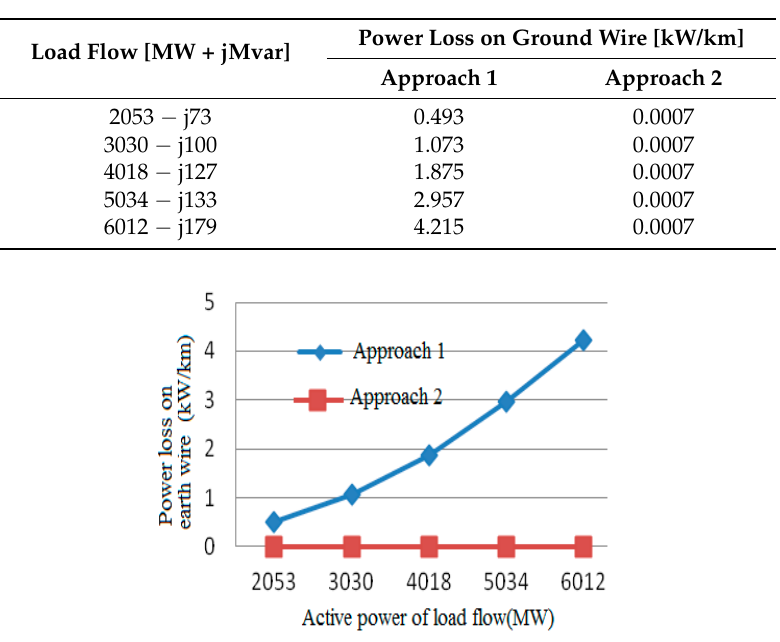
Table 6. Power loss on a UHV AC overhead line.